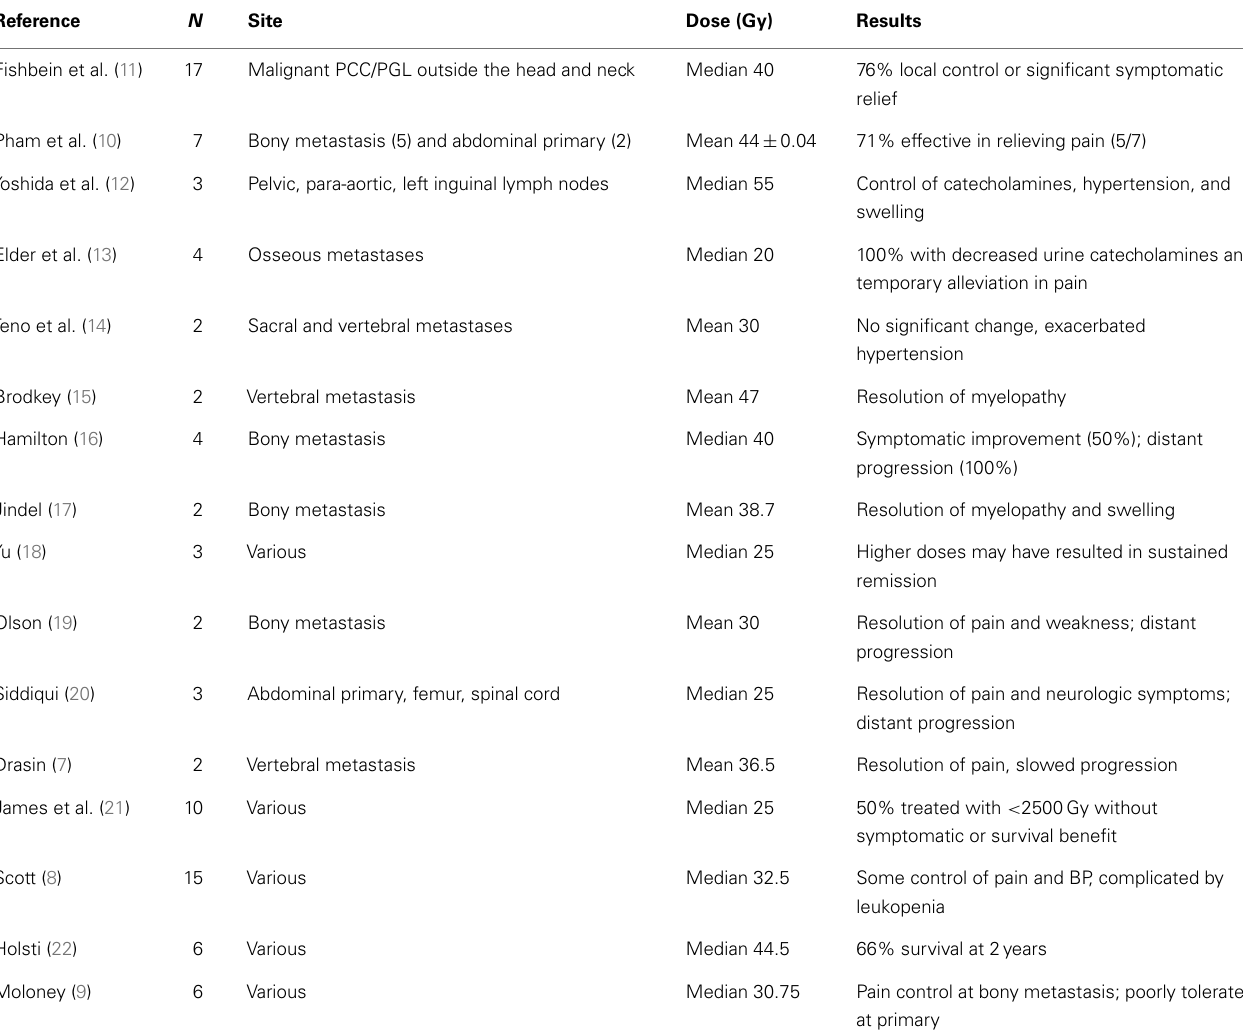
Table 1 | Malignant PCC/PGL cases treated to known total dose